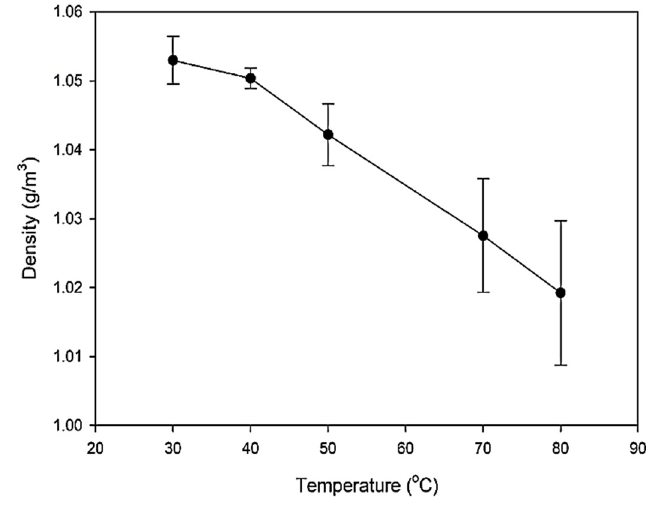
Figure 16. Density error of base fluid (experimental and ASHRAE Standard data).